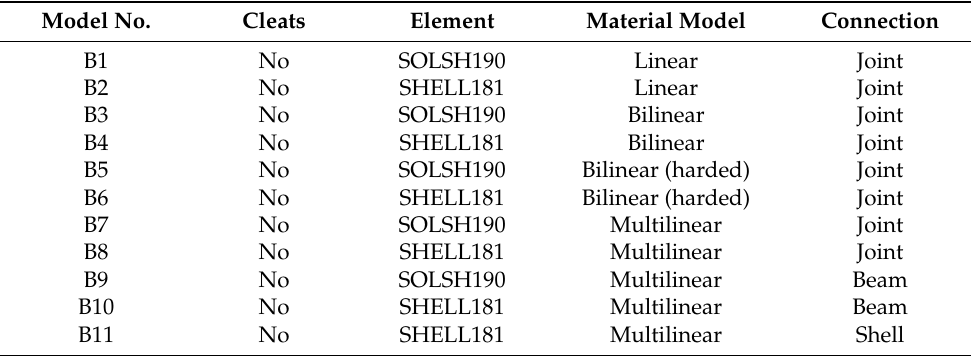
Table 2. Parameters of numerical models without